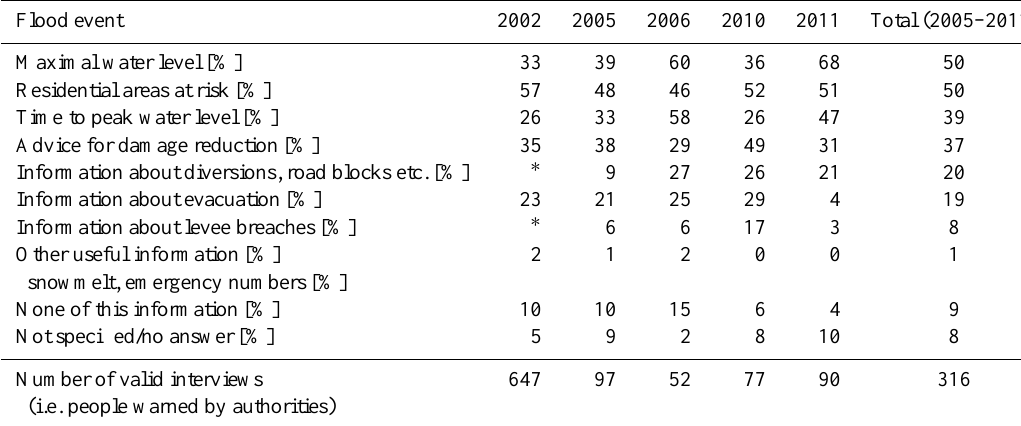
Table 7. Information content of official flood warnings (multiple answers possible).